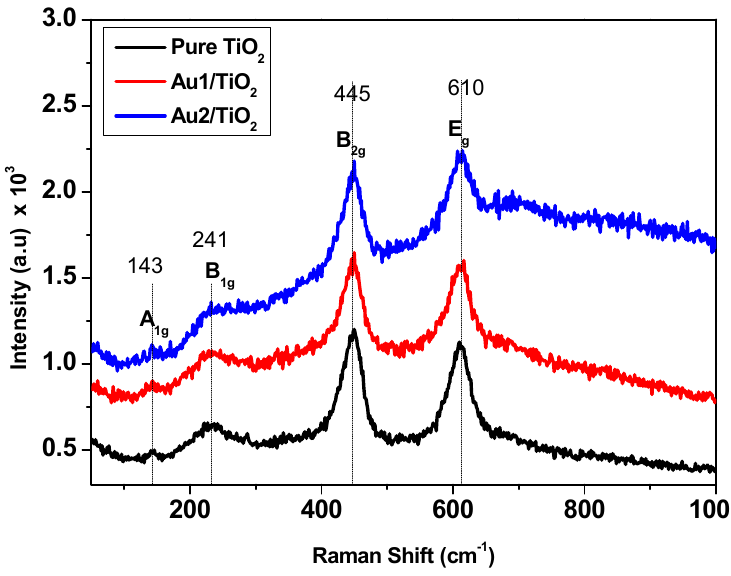
Figure 1. The Raman spectra of TiO 2 , Au1/TiO 2 , and Au2/TiO 2 samples.